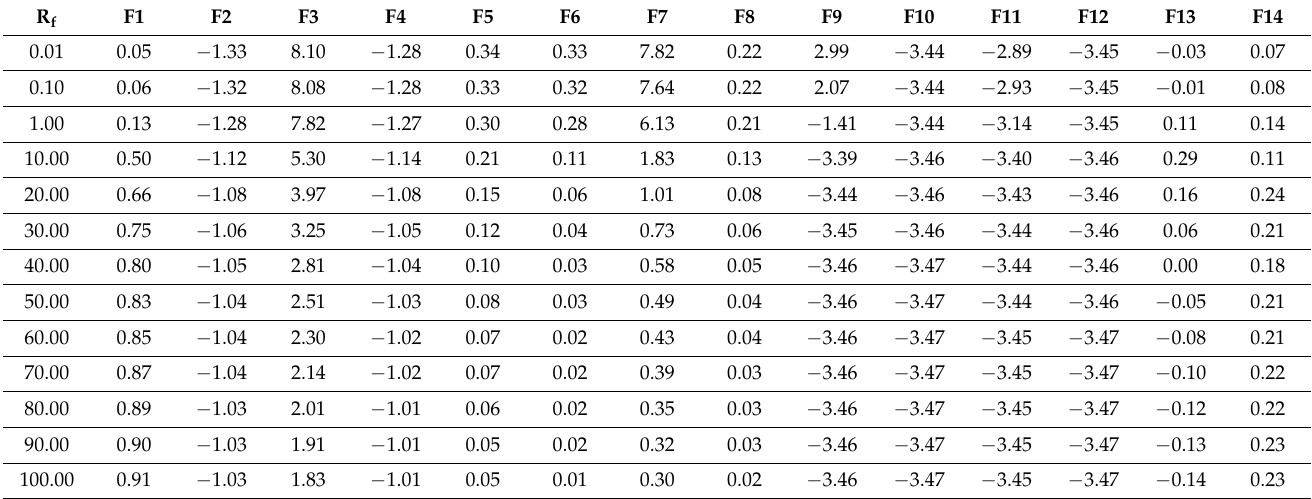
Table 3. Features at R1 for a positive line-to-ground fault at Line-1 with R f =1 ohm.